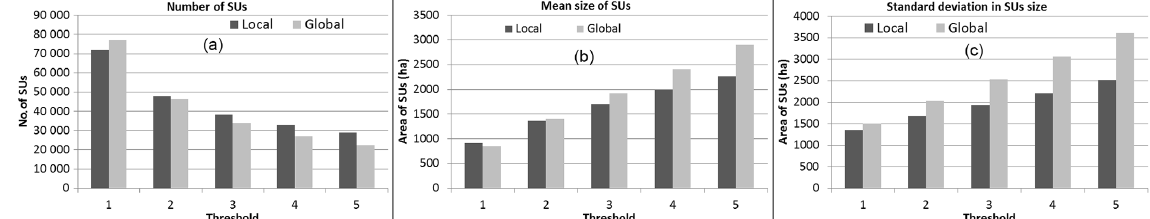
Figure 9. Comparison of the two methods (global and local) using non-geo-located SUs in terms of their sensitivity to different values of area threshold for the total number of SUs (a) , average SU size (b) and standard deviation in SU size (c) over the study area. SUs are constructed based on elevation, slope and